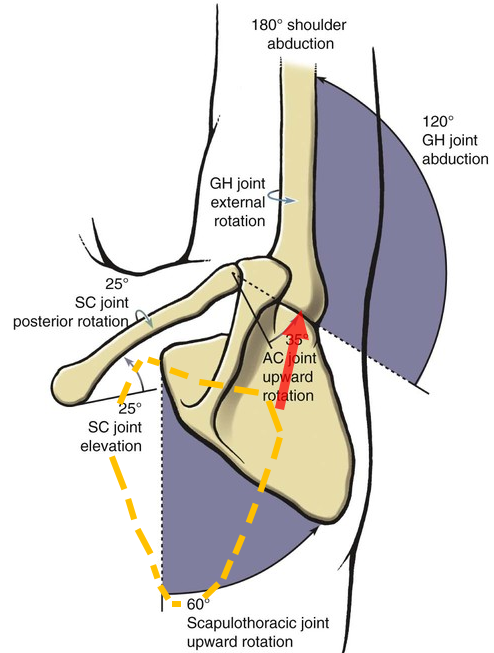
Figure 1. Rear view of the right shoulder complex (the shoulder abduction 180 ◦ ; Neumann,